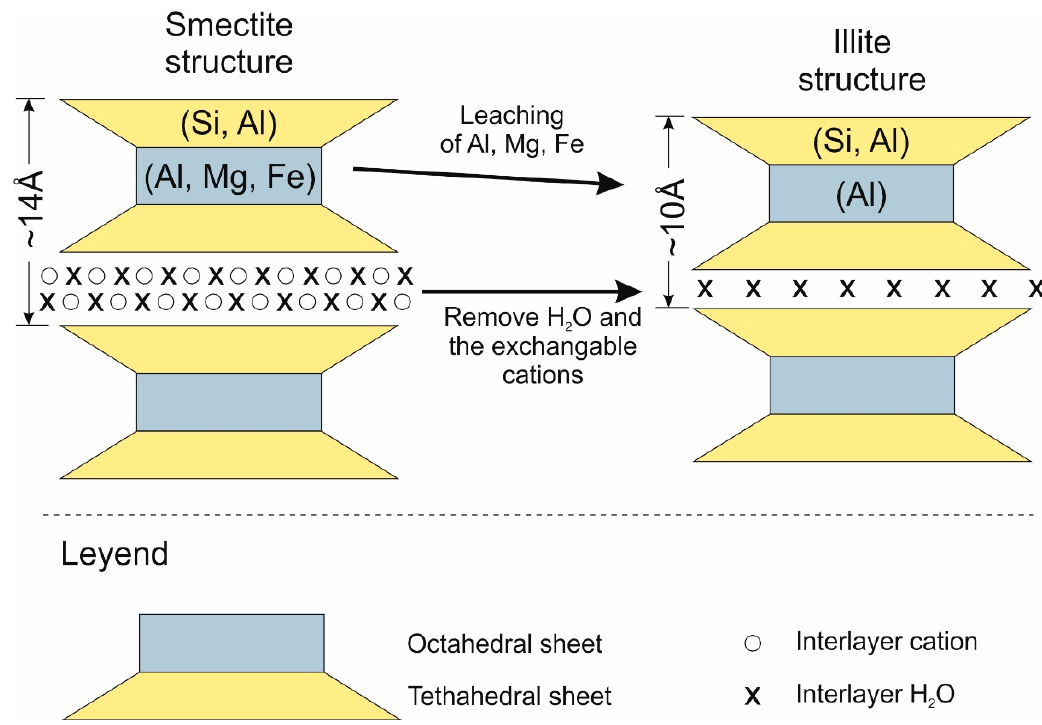
Figure 6. Schematic illustration of the proposed mechanisms for smectite illitization. Table 2. Al, Ca, Fe, K, Mg, Na, and Si in the supernatant reaction solutions by ICP-EOS. Element